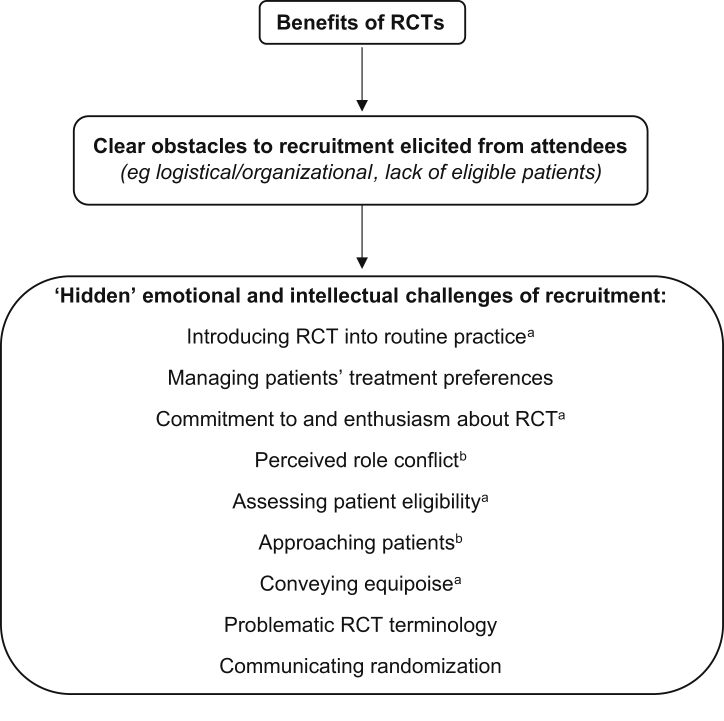
Content of the workshops. aCovered in greater depth with surgeons; bCovered in greater depth with research nurses. RCT, randomized controlled trial.